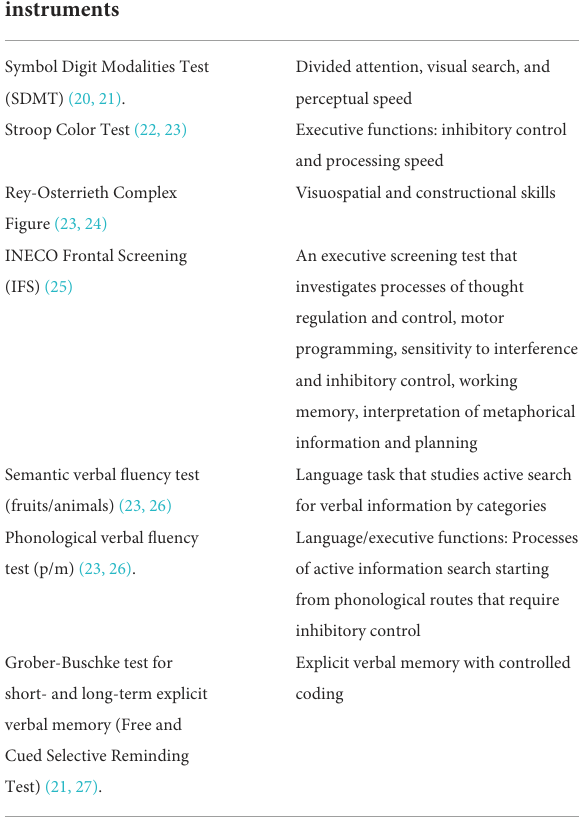
TABLE 1 Neuropsychological